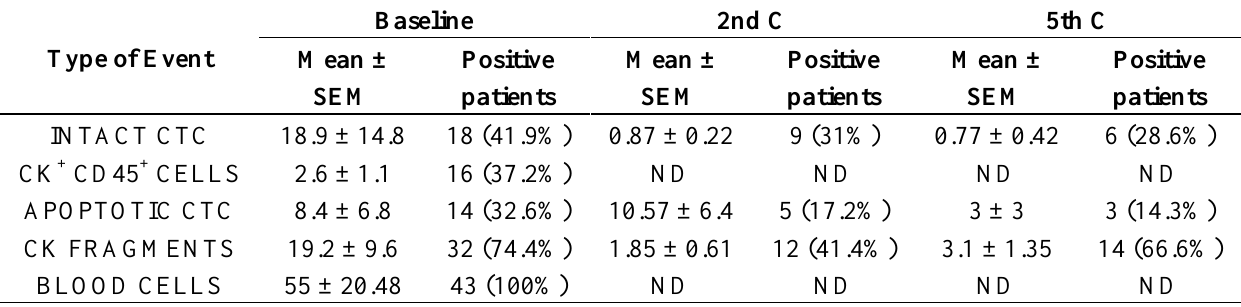
Table 2. Intact CTC and CTC-related object counts at baseline and over the course of therapy. Type of